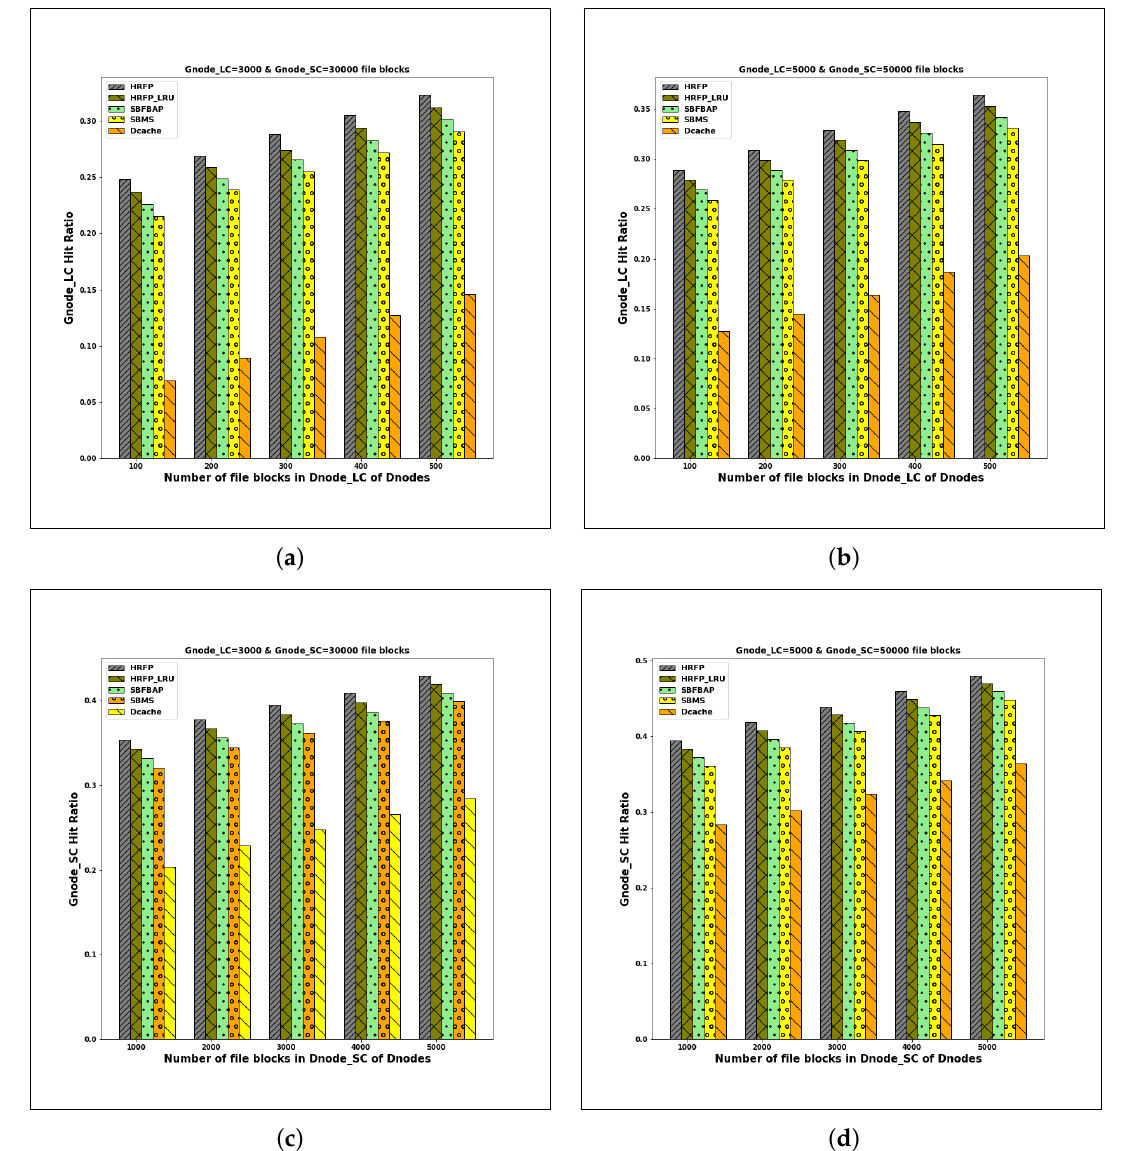
Figure 6. Figures ( a – d ) shows Hratio of GLcache and GScache when the sizes of them are set to 3000, 5000 file blocks and 30,000, 50,000 file